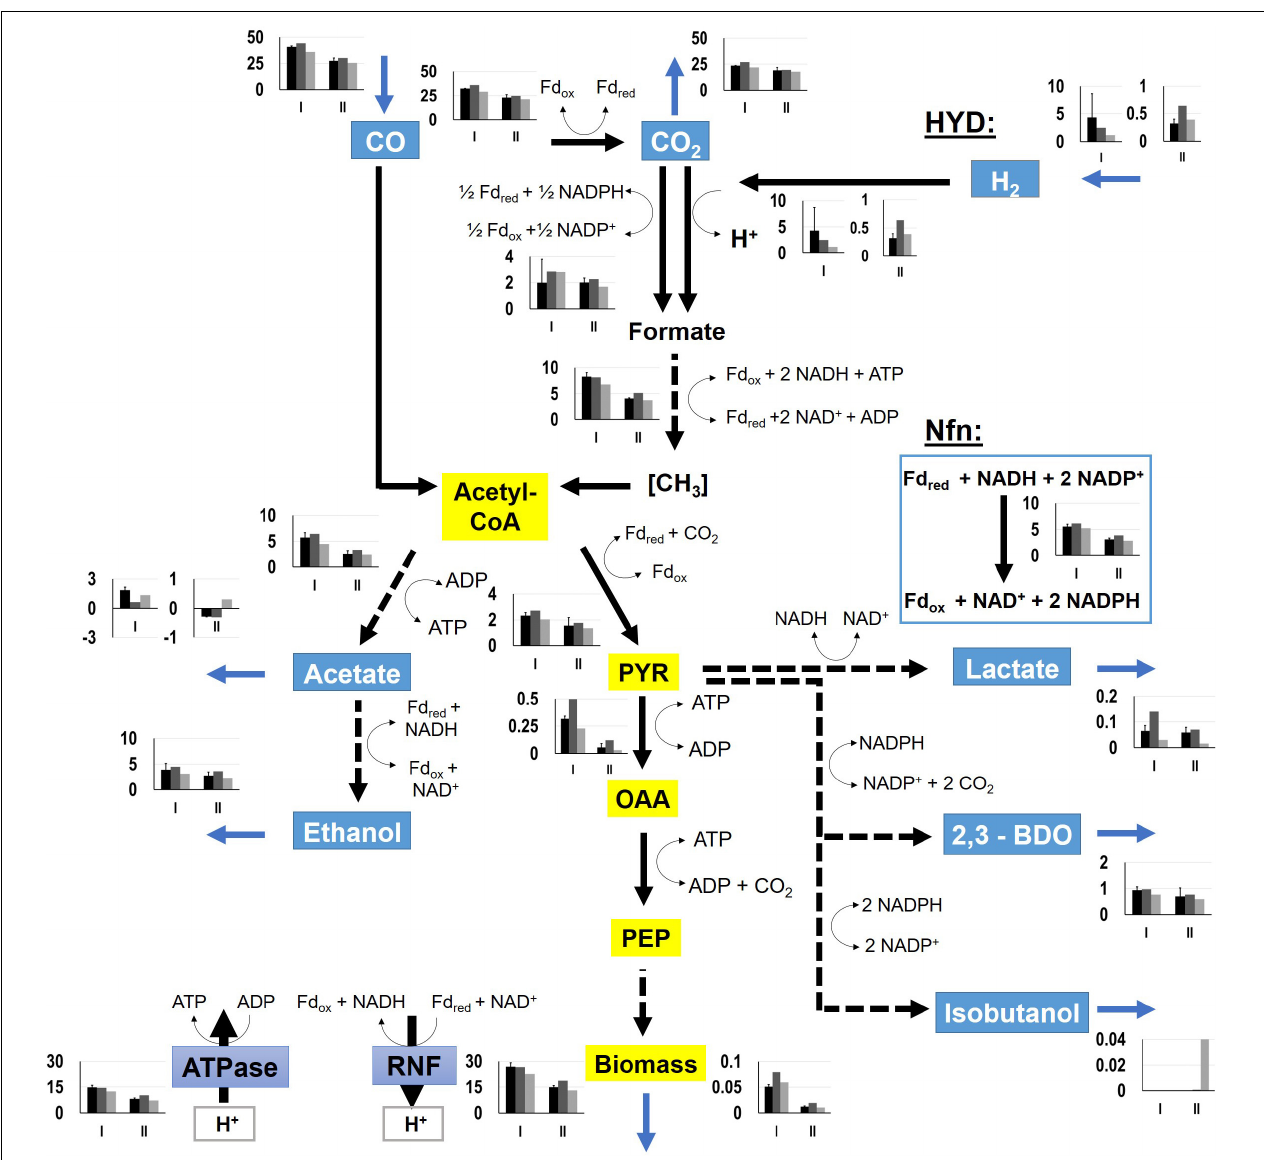
FIGURE 9 | Metabolic flux distributions of CLJU[WT, REF] (black) CLJU[KAIA] (dark gray), and CLJU[KAIA]:ilvE (light gray) based on the conversion of syngas in steadily gassed batch cultivations in stirred-tank bioreactors. Illustrated are the simulated fluxes in mmol (g CDW *h) − 1 for the first (I) and second (II) growth phase. Values of the wildtype cultivation indicate mean of duplicates.